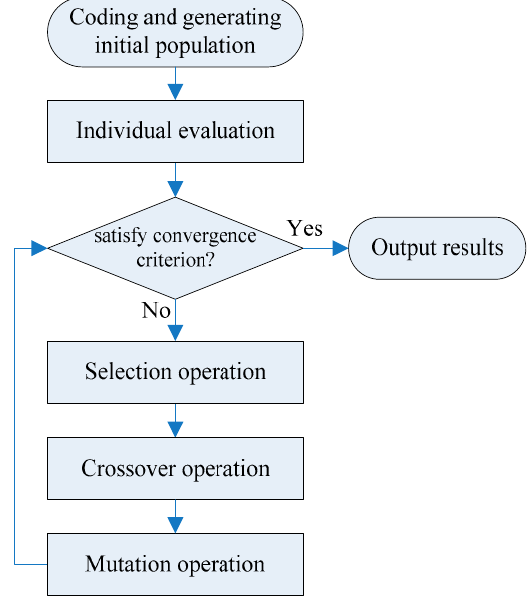
Figure 1. The flowchart of GA .